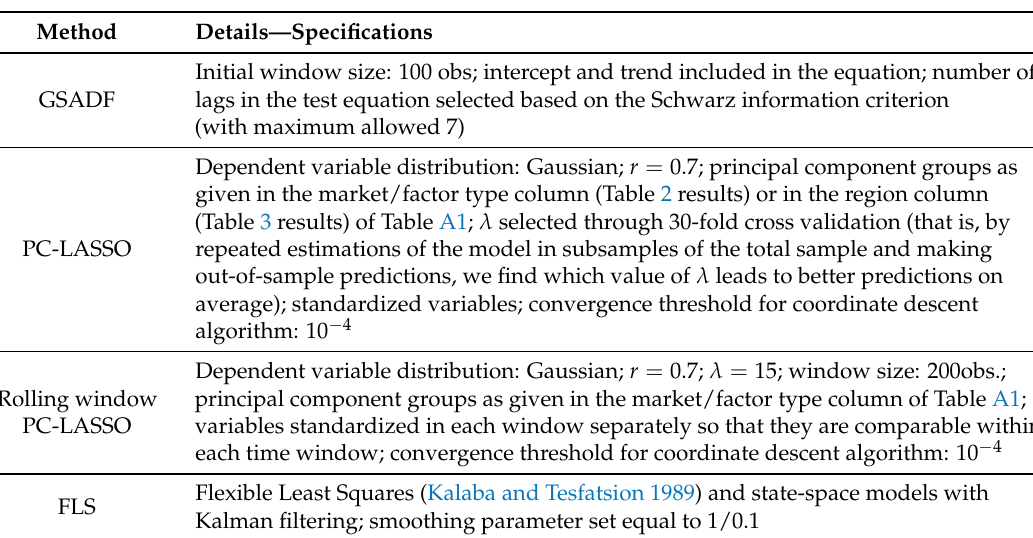
Table 1. Summary of methods